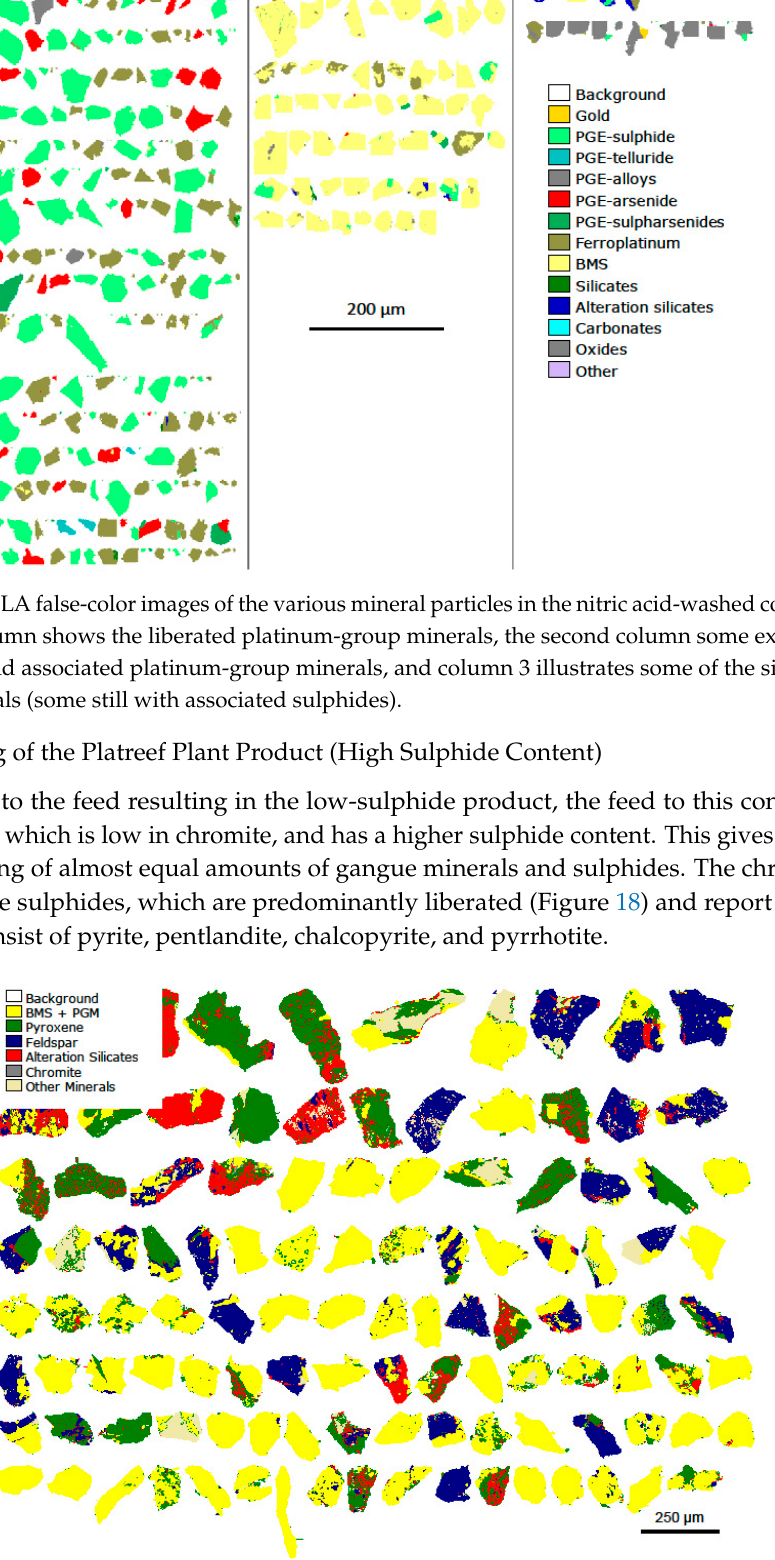
Figure 18. QEMSCAN false-color images of the various mineral particles in the Platreef plant product. Note the abundance of coarse liberated sulphides.